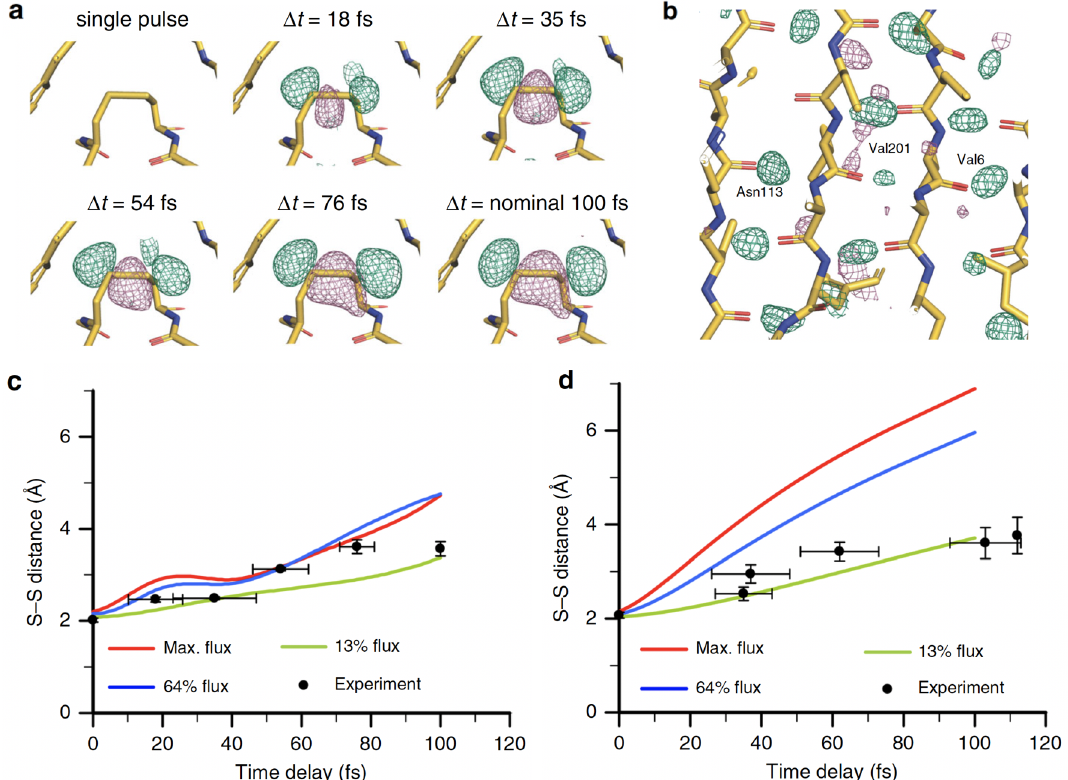
Figure 5. Pump-probe serial crystallography. ( a ) The dissociation of sulfur bridge in a thaumatin crystal observed with pump-probe crystallography at LCLS. ( b ) Isomorphic different density maps between the two-pulse experiment minus a single pulse measurement with positive density in green and isomorphic different density map of a β -sheet region in thaumatin, showing peaks near the carbonyl oxygen atoms. ( c ) Simulation of S-S dissociation in thaumatin with a molecular dynamics code (XMDYN) and ( d ) a simulation of lysozyme with a hybrid plasma-MD approach. Both simulations agree on the importance of Debye screening and ion-ion interactions in determining the sulfur dynamics. Reproduced